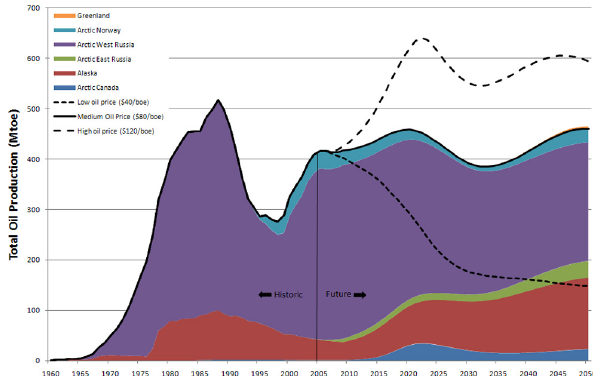
Fig. 2. Historic and estimated oil production in the Arctic with an oil price of $80/boe (by region) and compared to a low ($80/boe) and high ($80/boe) oil price.